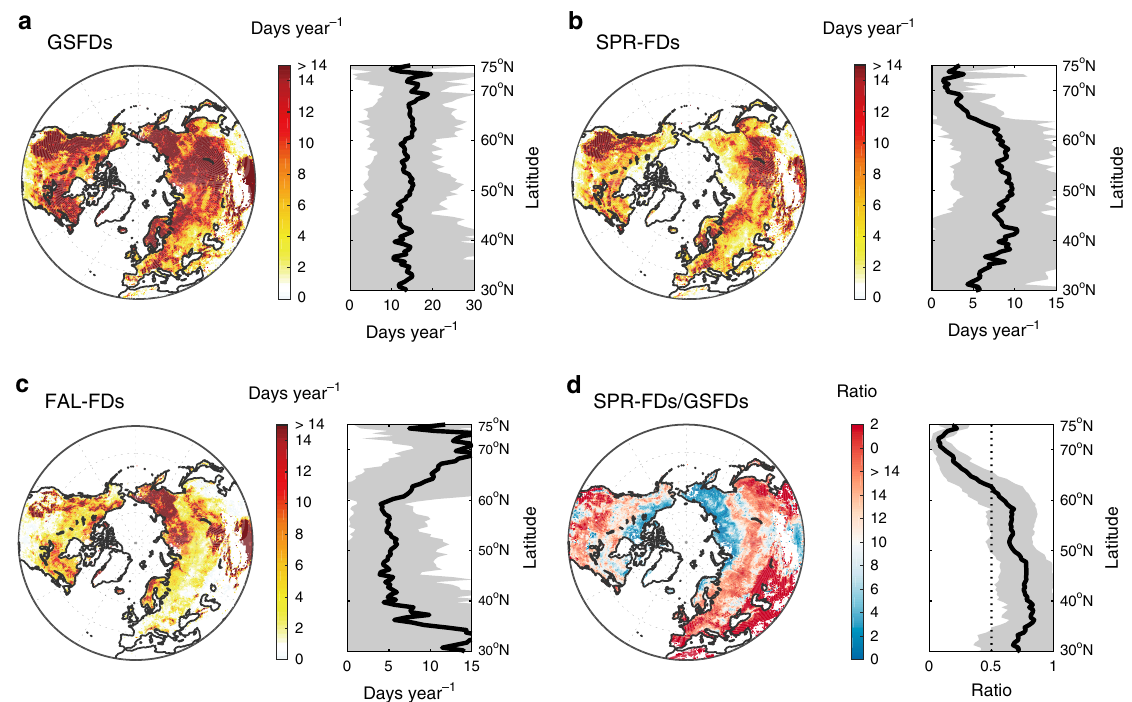
Fig. 1 Spatial distribution of average frost days during growing season for 1982 – 2012. The number of frost days in the Northern Hemisphere was averaged from the results of the Princeton and WFDEI data sets. a – c indicates frost days and their variation along the gradient of latitude (black line and gray area presents the average frost days and its standard deviation across latitudes, respectively) calculated during growing season (GSFDs, from SOS to EOS), spring (SPR-FDs, from SOS to summer solstice) and autumn (FAL-FDs, from summer solstice to EOS). d displays the ratio of the number of frost days between ( b ) and ( a ). Maps were created using Matlab